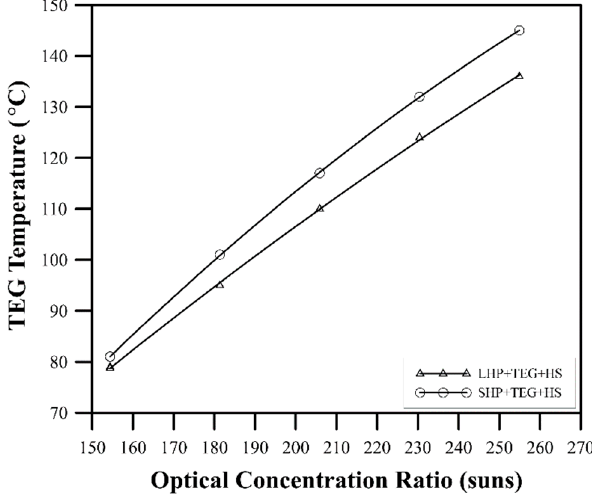
Figure 9. TEG hot-side temperatures attached to the long and the short HP, respectively, as a function of the optical concentration ratio.